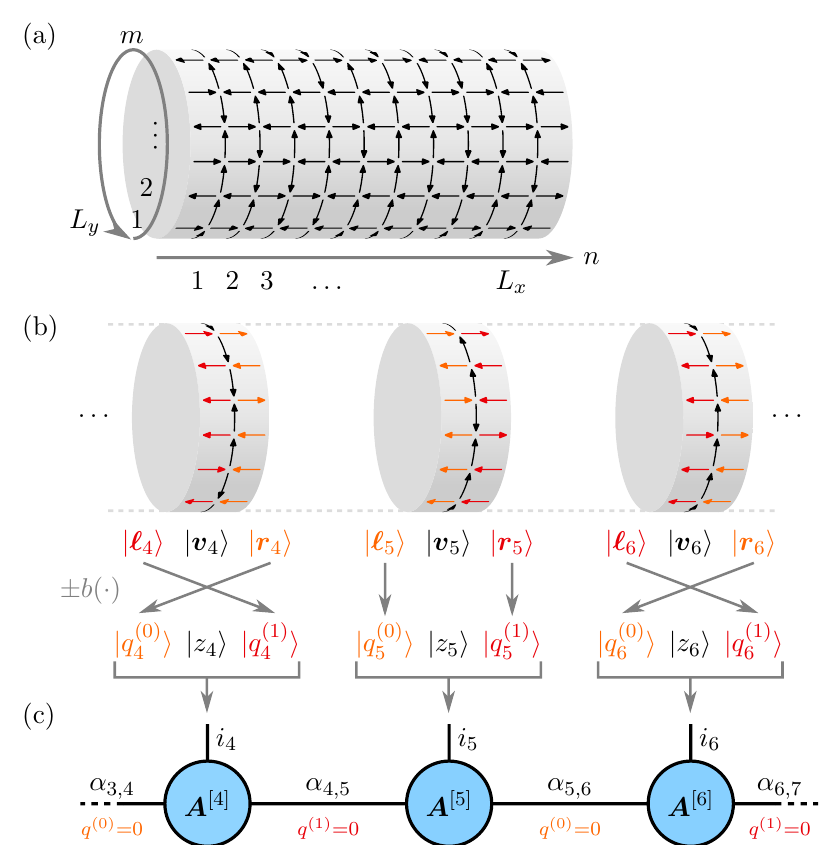
Figure 3: Mapping to MPS. (a) Cylindrical lattice. (b) Spins are grouped by compu- tational site n , and encoded in U ( 1 ) quantum numbers q ( k ) ing MPS segment with site-indices i α (shared lines). The full quantum state is encoded in the symmetry invariant n , n + 1 tensors A [ n ] (blue). A gauge invariant state has fixed quantum numbers q ( k ) = 0 on odd-even ( k = 0) and even-odd ( k = 1)